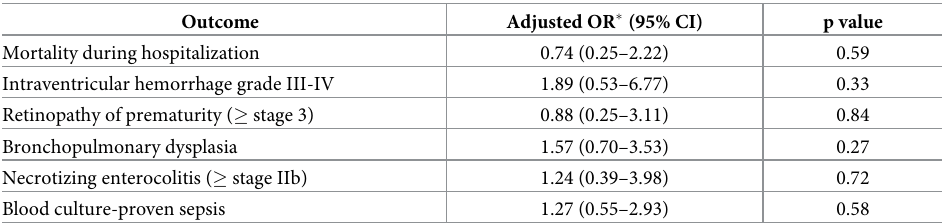
Table 2. Adjusted odds ratios for risk of adverse outcomes by presence of HS